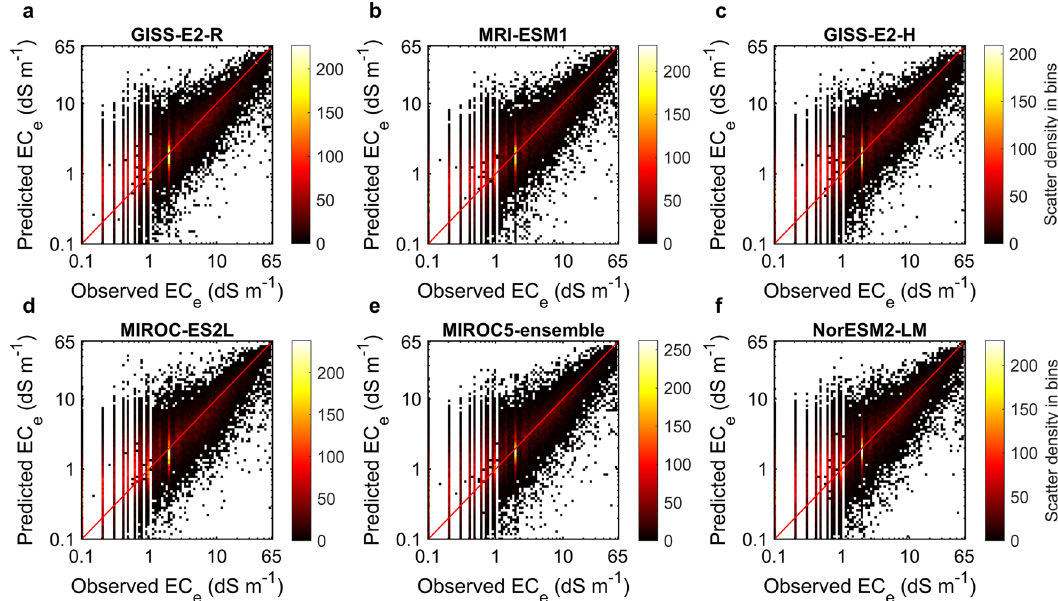
Fig. 5 10-fold cross-validation plots for the six trained models with the highest root mean squared error (RMSE) values out of the fi nal 16 best- fi tted models. The RMSE decreases from a – f . The colour maps show the scatter density in each bin. The red lines represent the y = x